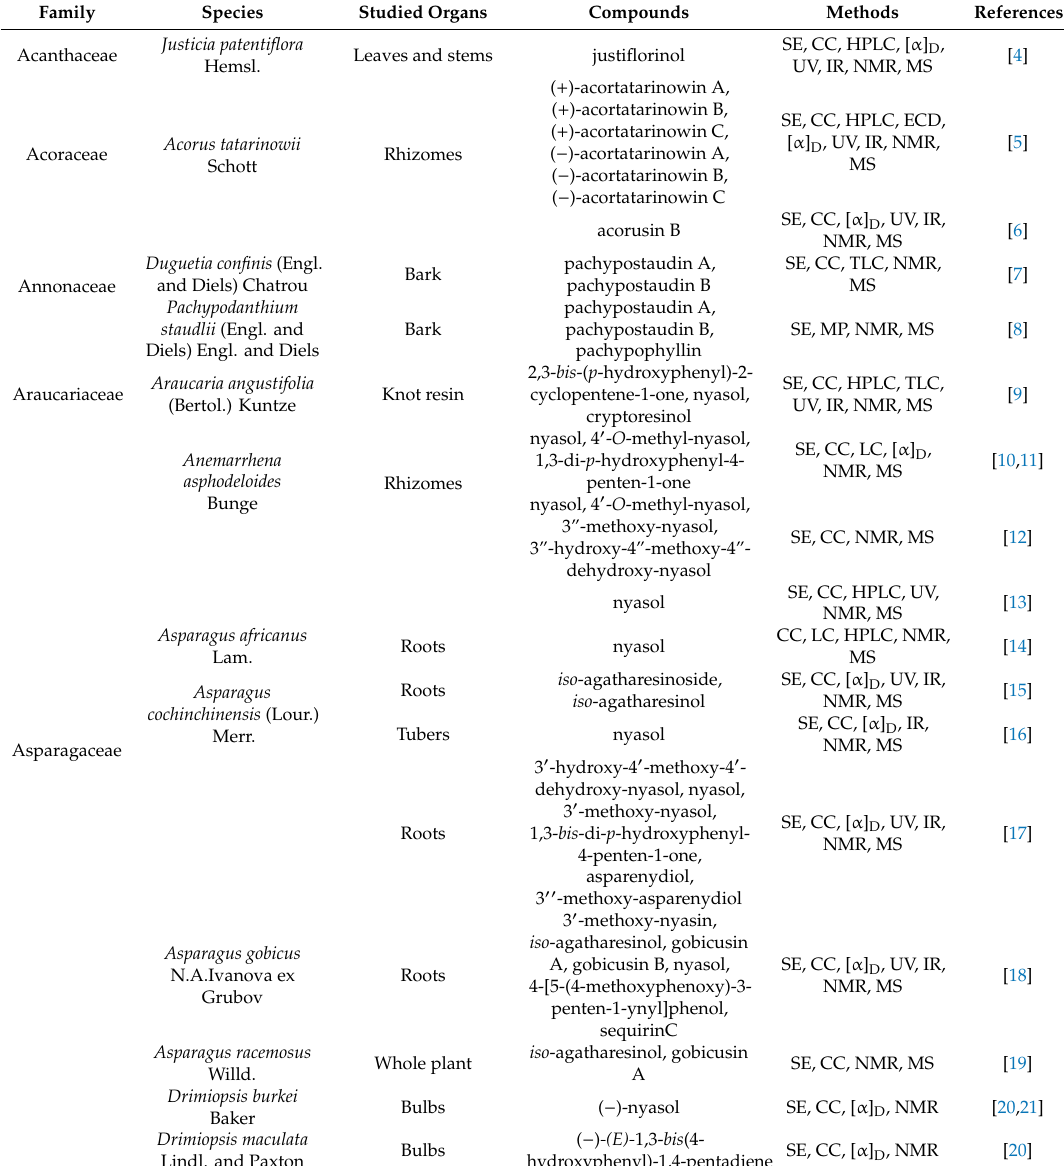
Table 1. of nor -lignans in the plant